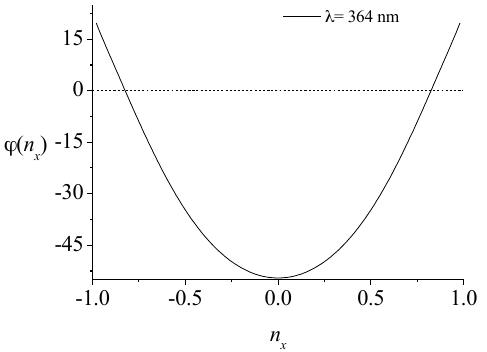
Figure 5. Phase function of the MD system containing three layers of metal.